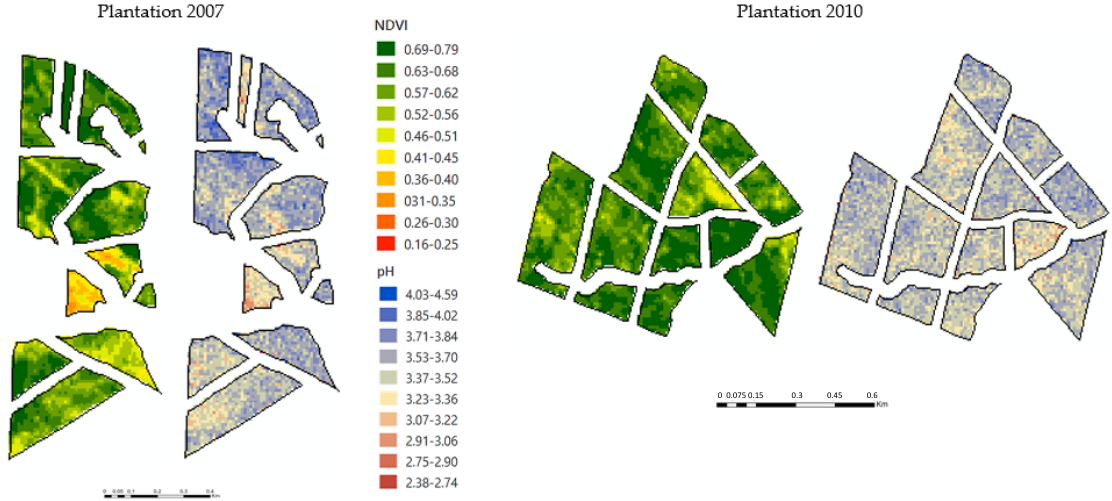
Figure 14. NDVI and pH model maps, 2018